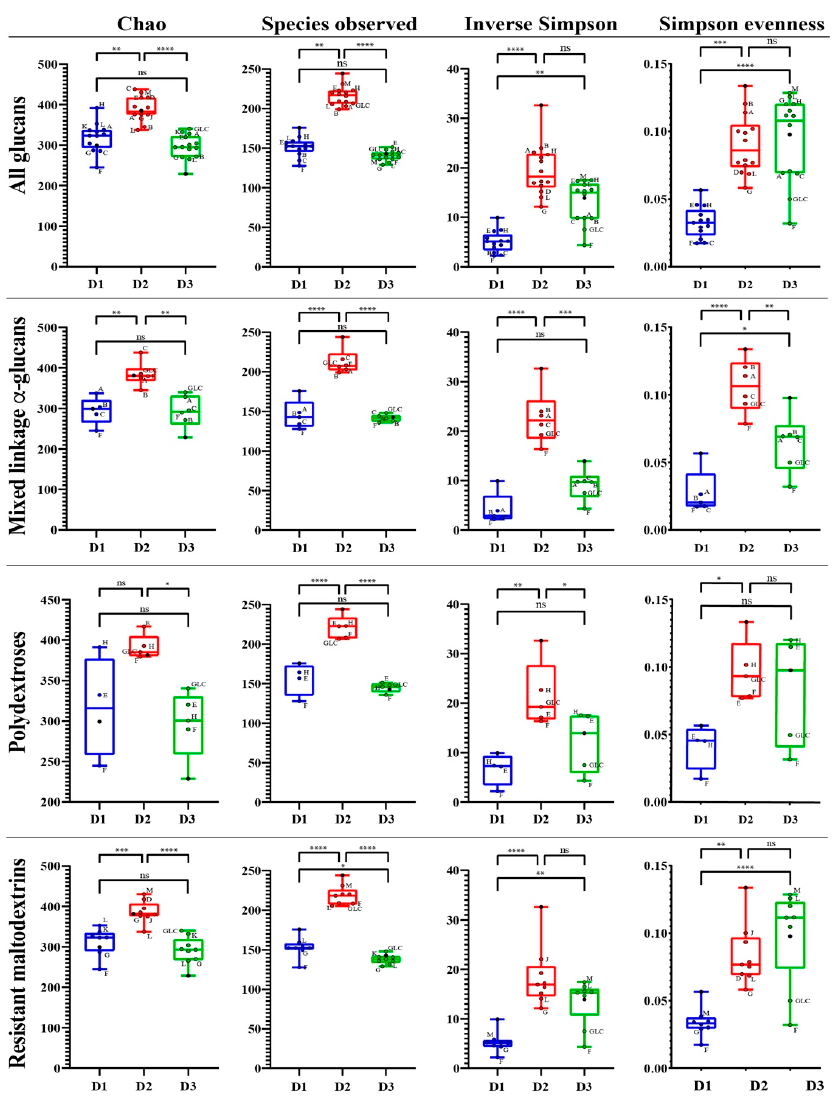
Figure 4. Comparison of alpha diversity metrics for community richness, evenness, and overall diversity among donors and within glucan categories, the initial fecal inoculum, and positive control groups containing glucose (GLC) and a fructan (F). Blue represents donor 1 (D1) microbiota, red represents donor 2 (D2) microbiota and green represents donor 3 (D3) microbiota. Measures of ini ‐ tial fecal samples are indicated by black filled dots; different glucans are indicated by their letters. For clarity, labels of glucans falling within the middle quartiles of the box and whisker plots are omitted from all glucan and resistant maltodextrin comparisons. Asterisks indicate statistical sig ‐ nificance (* = p < 0.05, ** = p < 0.01, *** = p < 0.001, and **** = p < 0.0001; ns = not significant at p < 0.05). Although all initial donor microbiomes were dominated by members of phylum Fir ‐ micutes (53%, 63%, and 54% for donors 1,2, and 3, respectively), they displayed very dif ‐ ferent initial microbiota structures. Each had at least one dominant OTU from phyla other than Firmicutes ; OTU00001 ( Prevotella copri , 37%) and OTU00006 ( Faecalibacterium